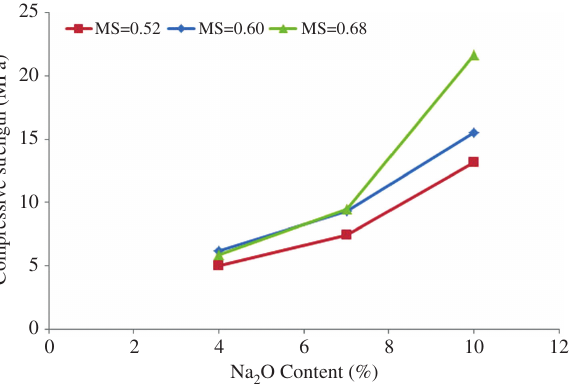
O on 28-day compressive strength for Figure 7 The effect of Na 2 samples cured at 85 ° C and constant MS.